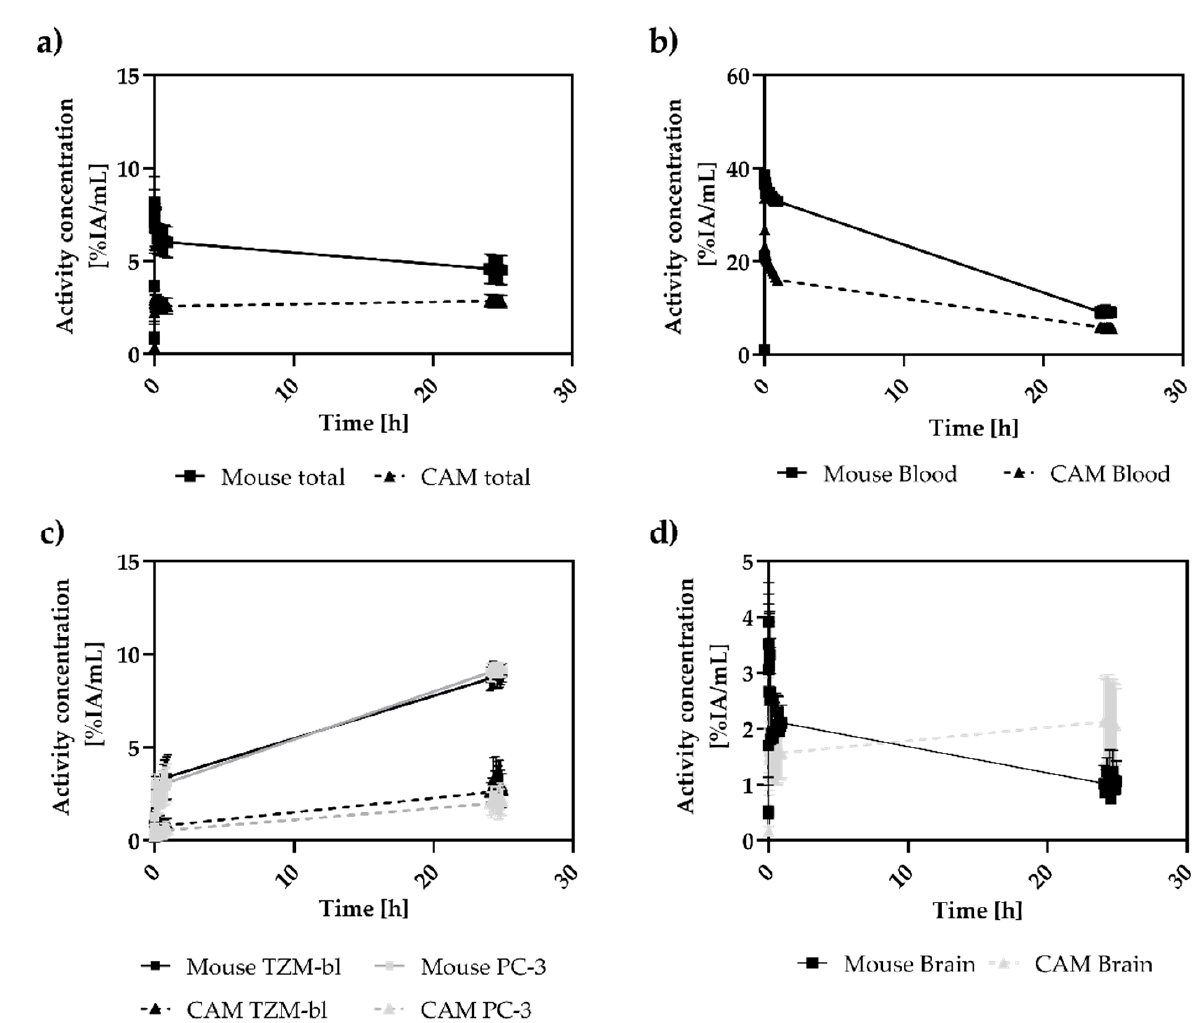
Figure 4. Depicted are the time–activity curves of both xenograft models: total activity in the different models ( a ), blood ( b ), TZM-bl and PC-3 tumors ( c ), and brain ( d ) over 24 h. In total, the activity concentration of the mouse tumors exceeds that of the CAM model ( p < 0.001). In contrast, the activity concentrations in the avian brains surpassed those of the mice after 24 h ( p < 0.001). However, within both xenograft systems, no differences in terms of accumulated activity in the different tumor entities can be detected.